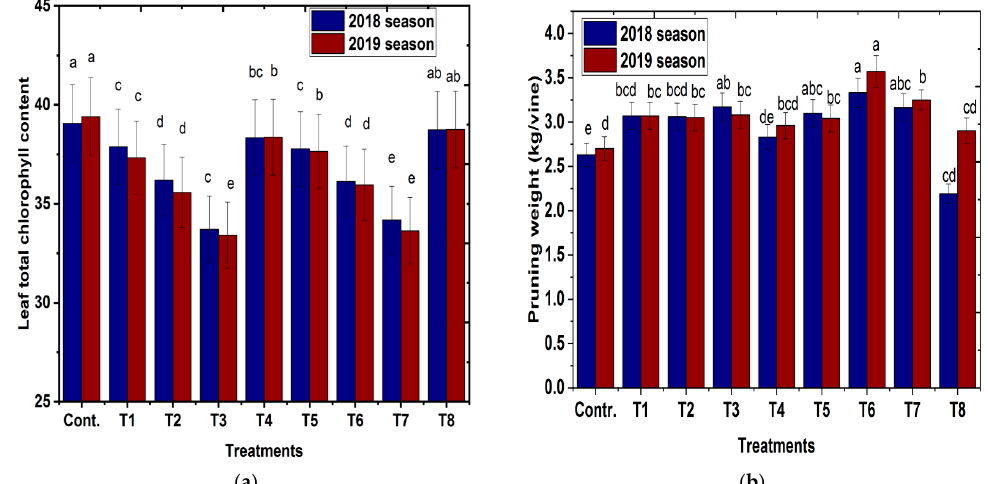
Figure 2. Effect of hand thinning and GA 3 spray sizing on ( a ) leaf chlorophyll content and ( b ) prun- ing weight of Sultanina grapevines (H4 strain) in 2018 and 2019 seasons. Contr.: without removing any shoulders of the cluster, T1:25% hand thinning + 20 ppm GA 3 sizing, T2:25% hand thinning + 30 ppm GA 3 sizing, T3:25% hand thinning + 40 ppm GA3 sizing, T4:25% hand thinning without GA 3 sizing, T5:50% hand thinning + 20 ppm GA 3 sizing, T6:50% hand thinning + 30 ppm GA 3 sizing, T7:50% hand thinning + 40 ppm GA 3 sizing and T8:50% hand thinning without GA 3 sizing. Means in each column followed by the same letter (s) are not significantly different at ( p ≤ 0.05), using Duncan’s Multiple Range Test.